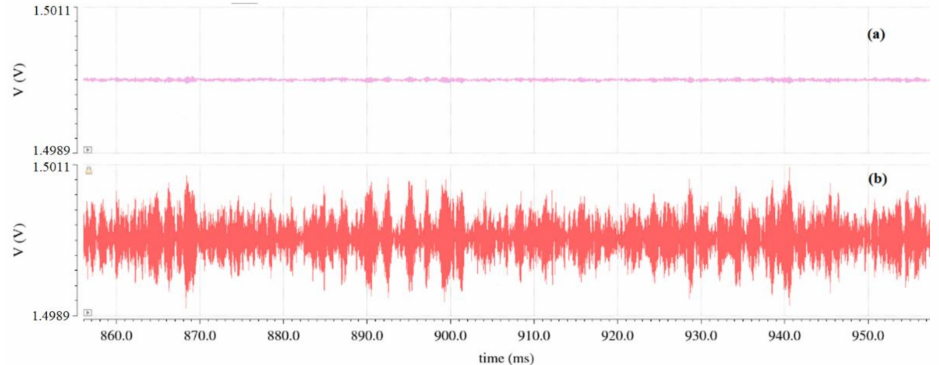
Figure 11. Transient noise analysis ( a ) at the preamplifier input and ( b ) at the preamplifier